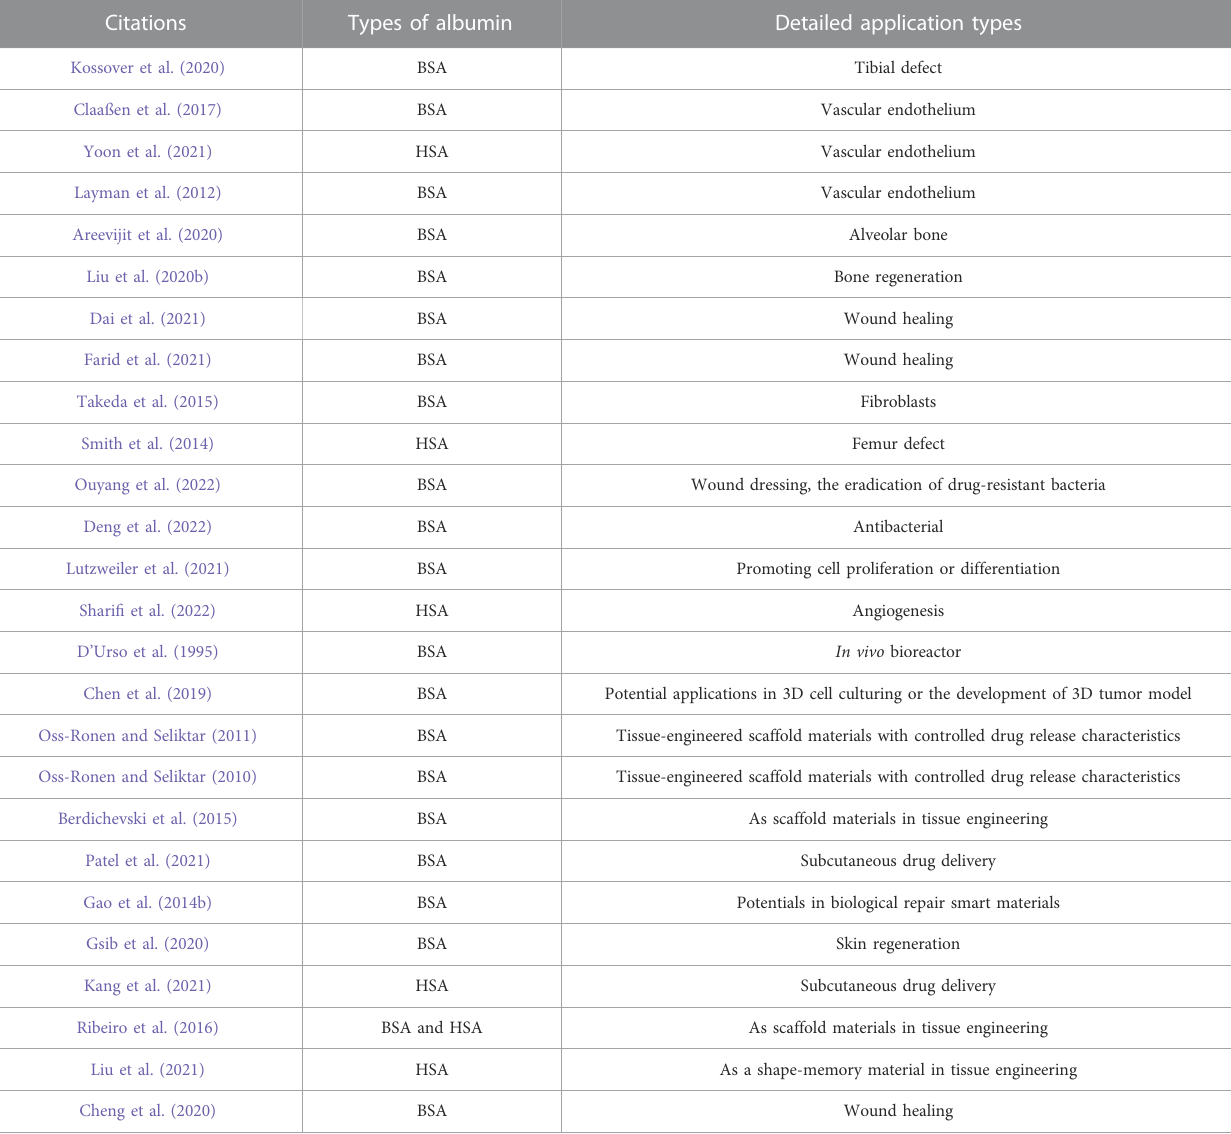
TABLE 3 Applications of albumin-based hydrogels in tissue regeneration engineering